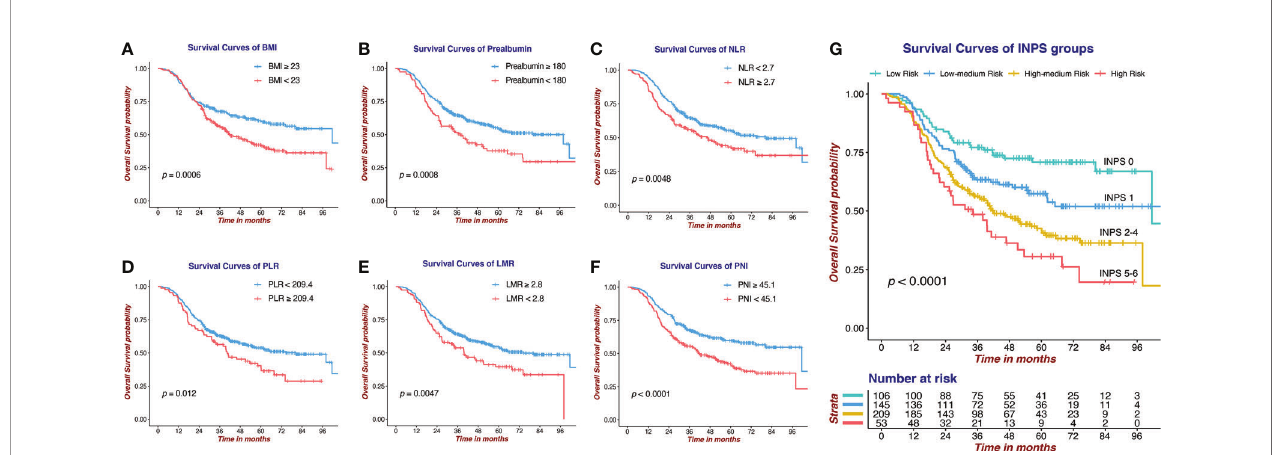
FIGURE 3 | Survival curves via Kaplan-Meier analysis of 6 nutritional and In fl ammatory biomarkers and INPS groups. (A) Survival curves of BMI ( ≥ 23 vs <23). (B) Survival curves of Prealbumin ( ≥ 180 vs <180). (C) Survival curves of NLR (<2.7 vs ≥ 2.7). (D) Survival curves of PLR (<209.4 vs ≥ 209.4). (E) Survival curves of LMR ( ≥ 2.8 vs <2.8). (F) Survival curves of PNI ( ≥ 45.1 vs <45.1). (G) Survival curves of INPS groups (score 0 vs 1 vs 2-4 vs 5-6). INPS, in fl ammatory-nutritional prognostic score; BMI, body mass index; NLR, neutrophil-lymphocyte ratio; PLR, platelet-lymphocyte ratio; LMR, lymphocyte-monocyte ratio; PNI, prognostic nutritional index.